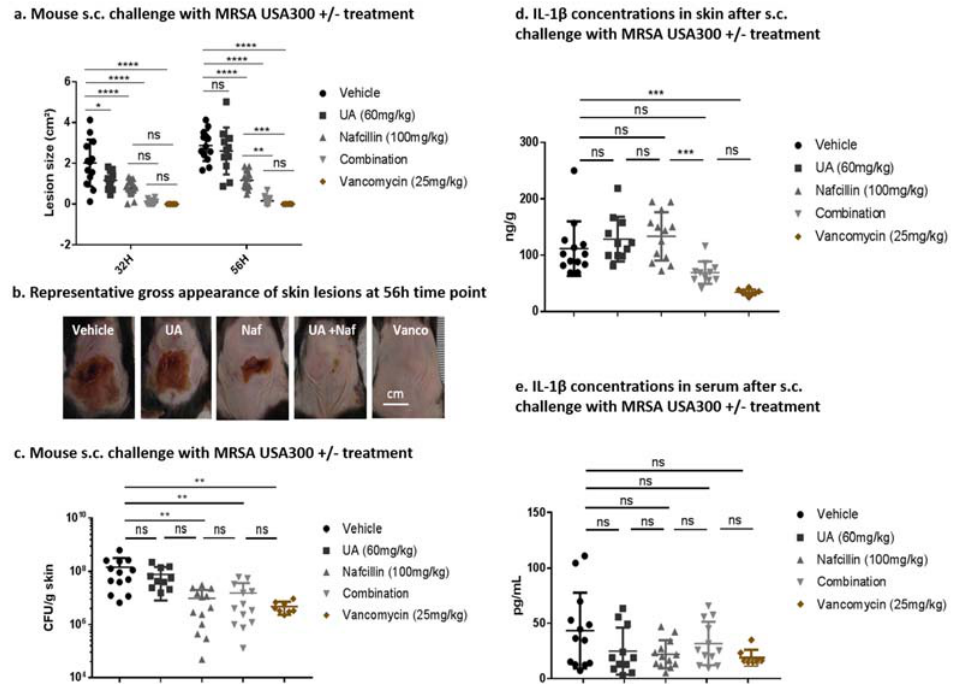
Figure 5. Antibacterial effects of UA in combination with nafcillin in a murine model of skin infection. Female c57/bl6 mice were infected with MRSA USA300 UAMS1516, followed by treatment with UA, nafcillin, a combination of both or vancomycin (positive control). ( a ) Lesion size (cm 2 ) after 32 h and 56 h and ( b ) representative lesions at 56 h are shown. ( c ) CFU/g skin of MRSA recovered from skin lesions harvested from animals at 56 h time point. ELISA analysis of IL-1 β (ng/g skin) levels recovered from skin lesions ( d ) or from serum (pg/mL) ( e ) harvested from animals after 56 h. Statistical analyses were performed by Tukey’s multiple comparison test (**** p < 0.001; *** p < 0.005; ** p <0.01; * p <0.05; ns, p >0.05).